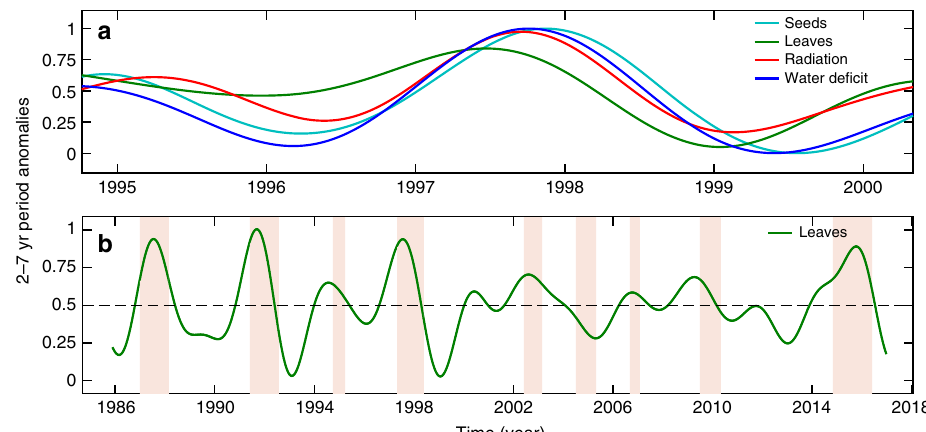
Fig. 5 Anomalies are higher during strong ENSO events and lower after these events. a Anomalies of solar radiation, soil water de fi cit, leaf fall, and seed fall around the time of the 1997 – 1998 El Niño event. Note that the peak of leaf fall preceded peaks of radiation and soil water de fi cit, while the peak in seeds lagged behind. b Anomalies of leaf fall over the entire record show peaks during El Niño events (shaded areas) identi fi ed based on Oceanic Niño Index values >0.5 °C for at least fi ve consecutive months. All series are normalized between 0 and 1 to facilitate visual comparison. X -axis ticks indicate January